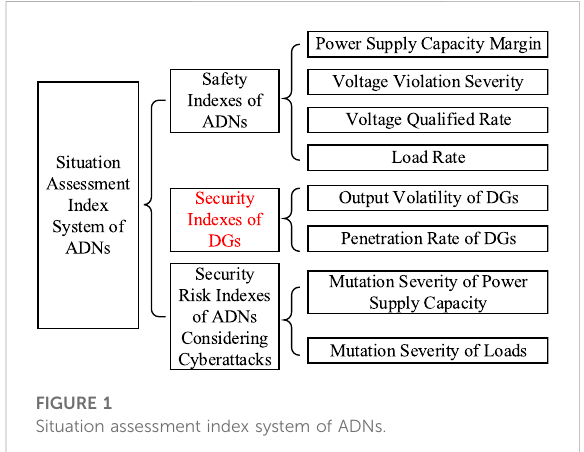
FIGURE 1 Situation assessment index system of